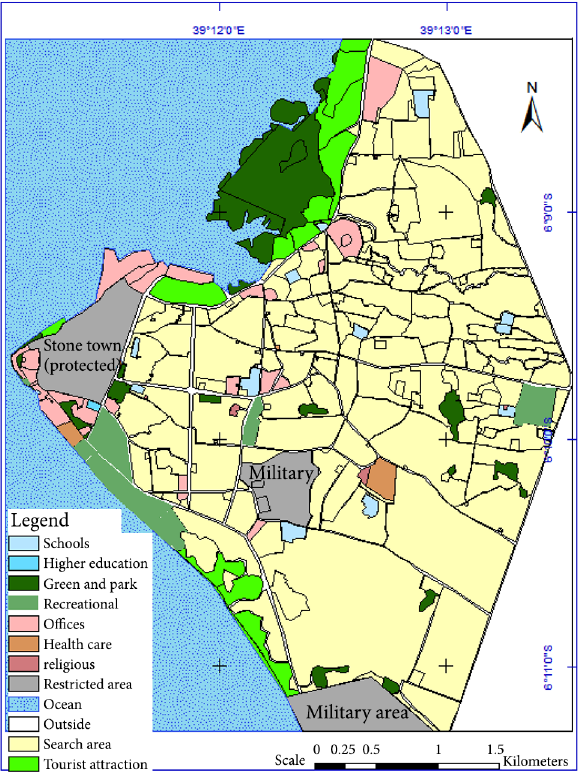
Figure 4. Raster map of Zanzibar used as input to the algorithm, with cells that were restricted (constrained) and the search area, for land-use